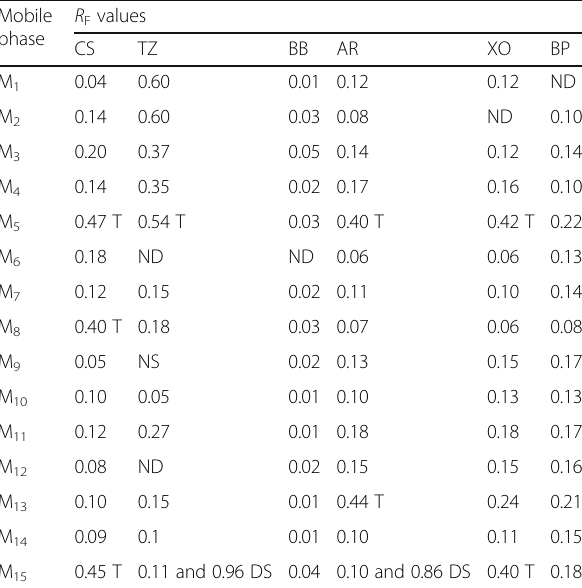
Table 6 Mobility of dyes in terms of R F values on stationary phase S 4 with different mobile phases Mobile phase